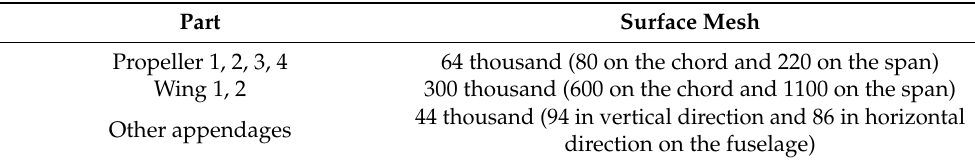
Table 3. Surface grid description.